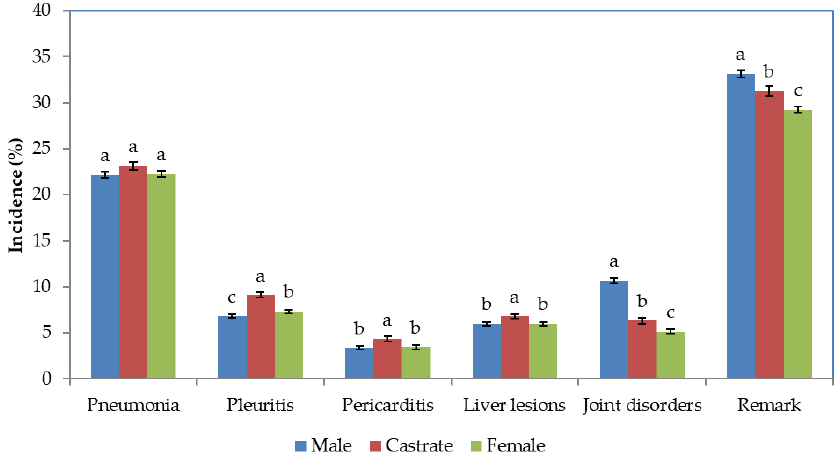
Figure 1. Least-squares means and standard errors of Incidences (%) of different remarks in different sexes. The standard errors are shown by vertical lines. Bars which do not share a common letter superscript were significantly different. There were significant ( p < 0.001) differences sexes denoted by different letters.